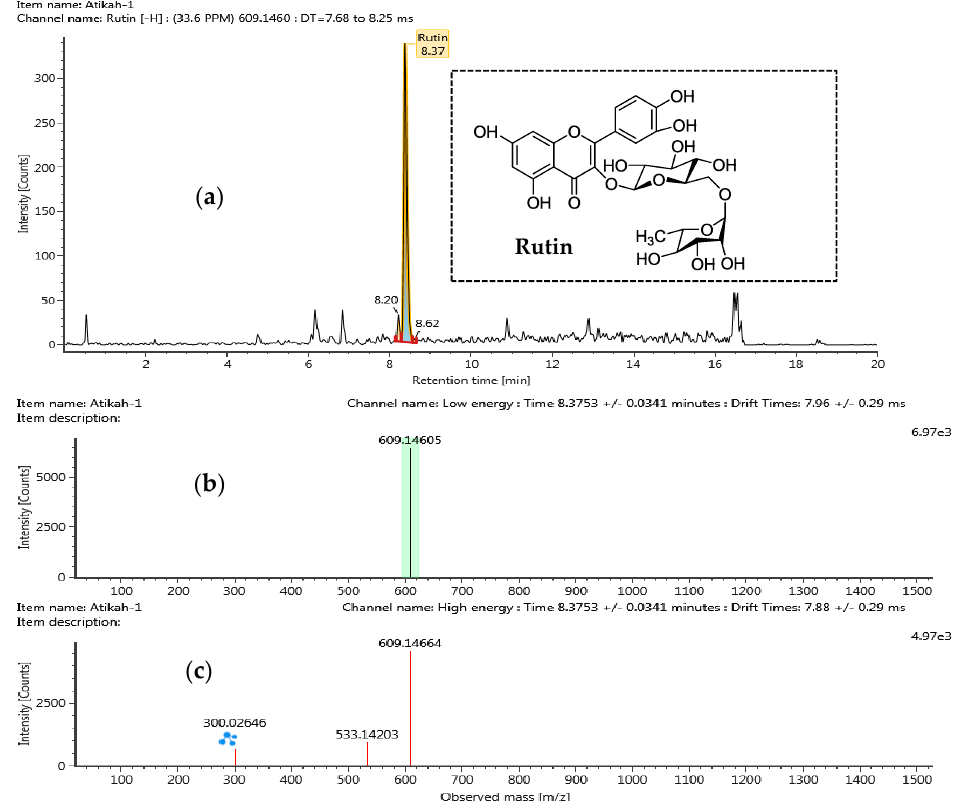
Figure 3. UPLC-QTOF/MS chromatograms of Rutin from defatted pitaya seed extract (DPSE): ( a ) mass spectra (MS/MS) of Rutin obtained at low collision energy; ( b ) mass spectra (MS/MS) of Rutin obtained at high collision energy ( c ).